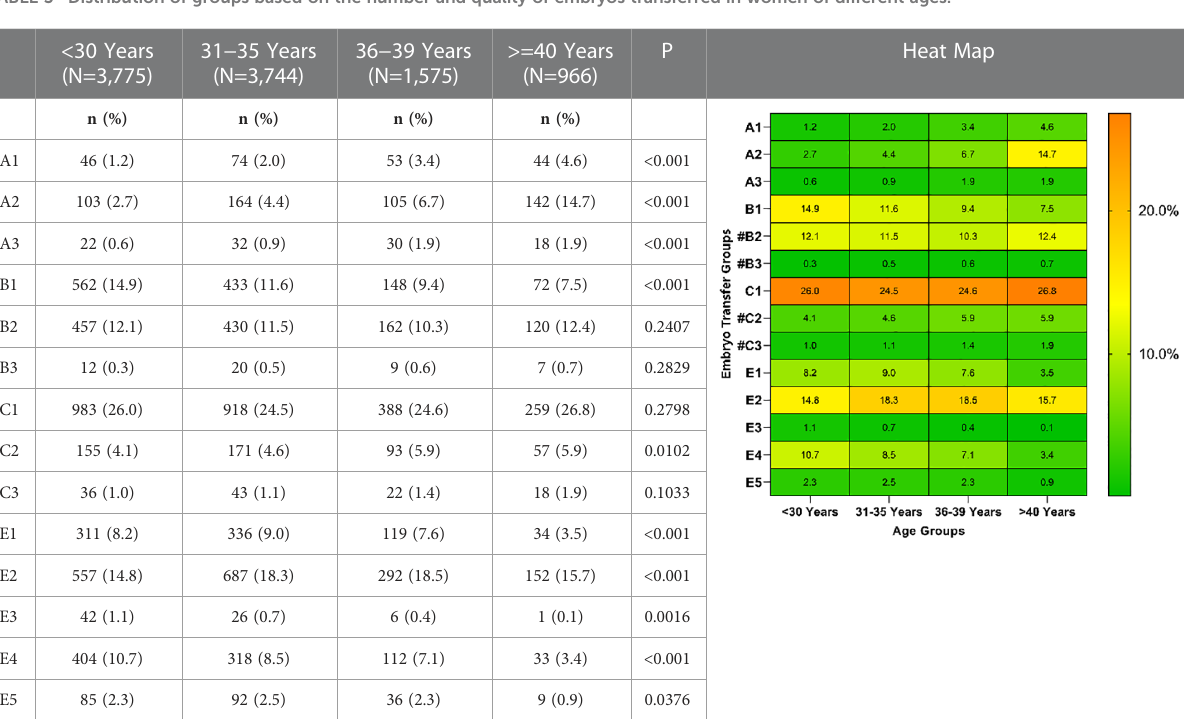
TABLE 3 Distribution of groups based on the number and quality of embryos transferred in women of different ages.